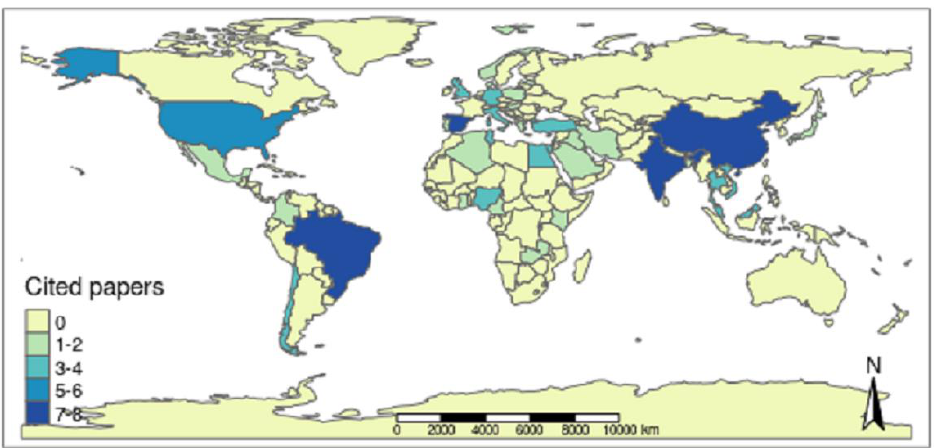
Figure 6. Frequency of scientific articles selected in the integrative review on microbiological diag- noses of Salmonella spp. in aquaculture between 2000 and 2020 by countries in different continents.